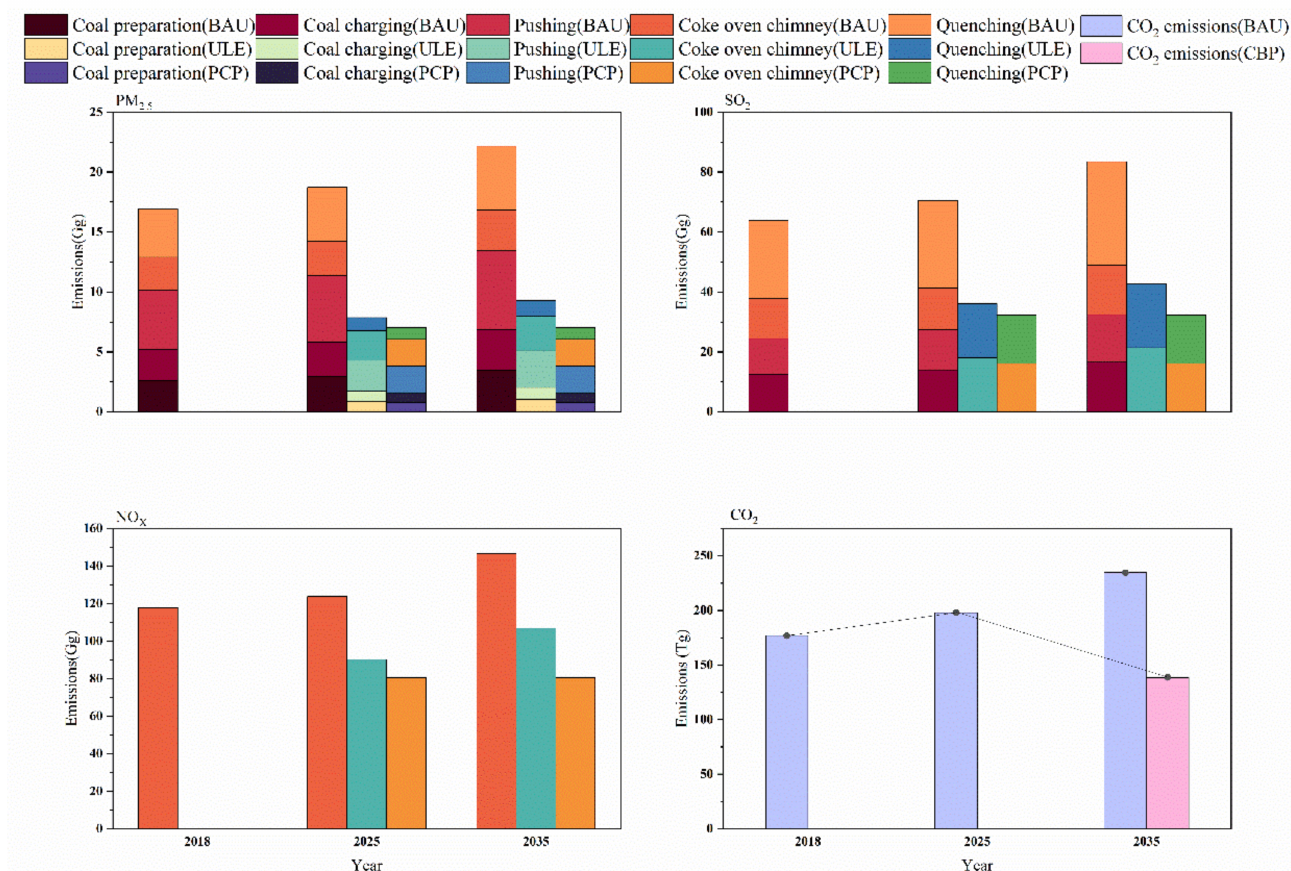
Figure 6. Emissions of air pollutants and CO 2 in China’s independent coking industry under different